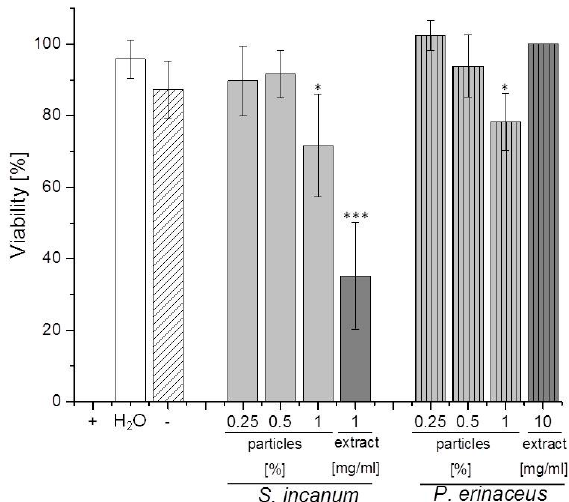
Figure 5. Activity of particle suspensions and methanolic extracts of S. incanum and P. erinaceus against the nematode S. feltiae . Experimental details are provided in the text. Negative controls (H 2 O) and Plantacare 1% ( − ) and a positive control (+) of 70% ethanol were used. Experiments were performed in triplicate and on at least two different occasions. Statistical significances were calculated using one-way ANOVA (OriginPlus). * p < 0.05, *** p < 0.005.